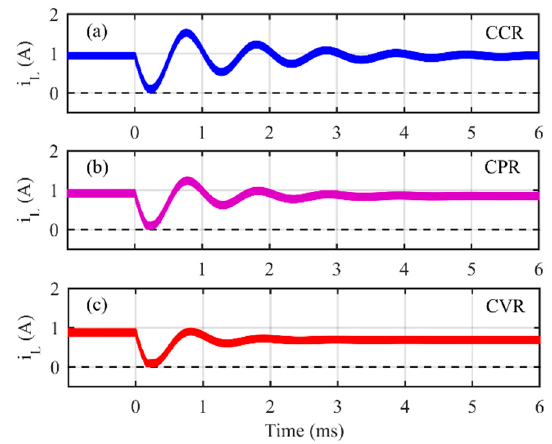
Figure 11. The behavior of inductor current when step-changes of 0.075 is applied ( a ) in CCR, ( b ) in CPR, and ( c ) in CVR.